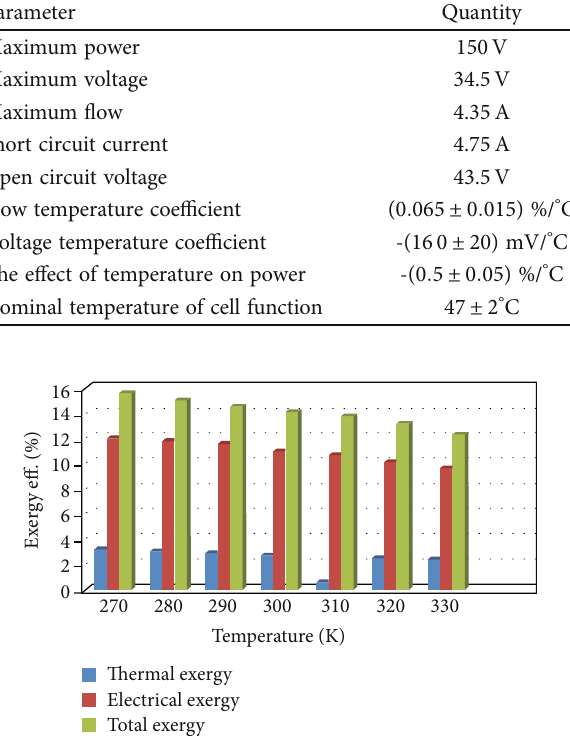
Figure 3: E ff ect of inlet air temperature change on exergy e ffi ciency.